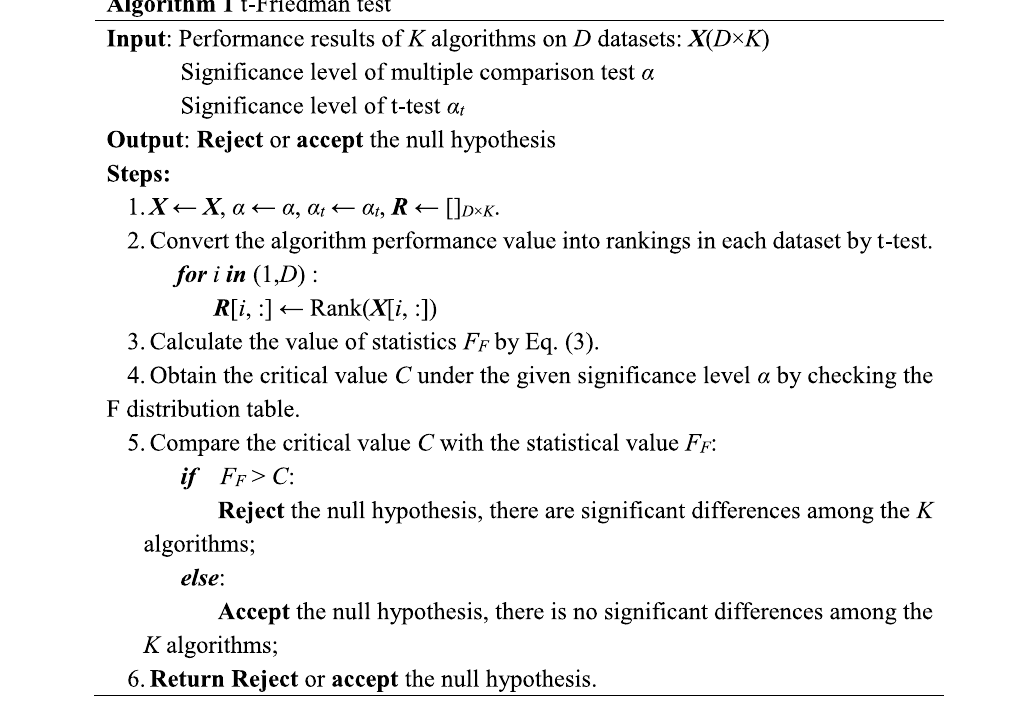
algorithm ( j = 1) is the control algorithm, and that the num- ber of datasets is N . The value X ij is the performance result of the j -th algorithm on the i -th dataset. The value of the algorithm performance is randomly generated according